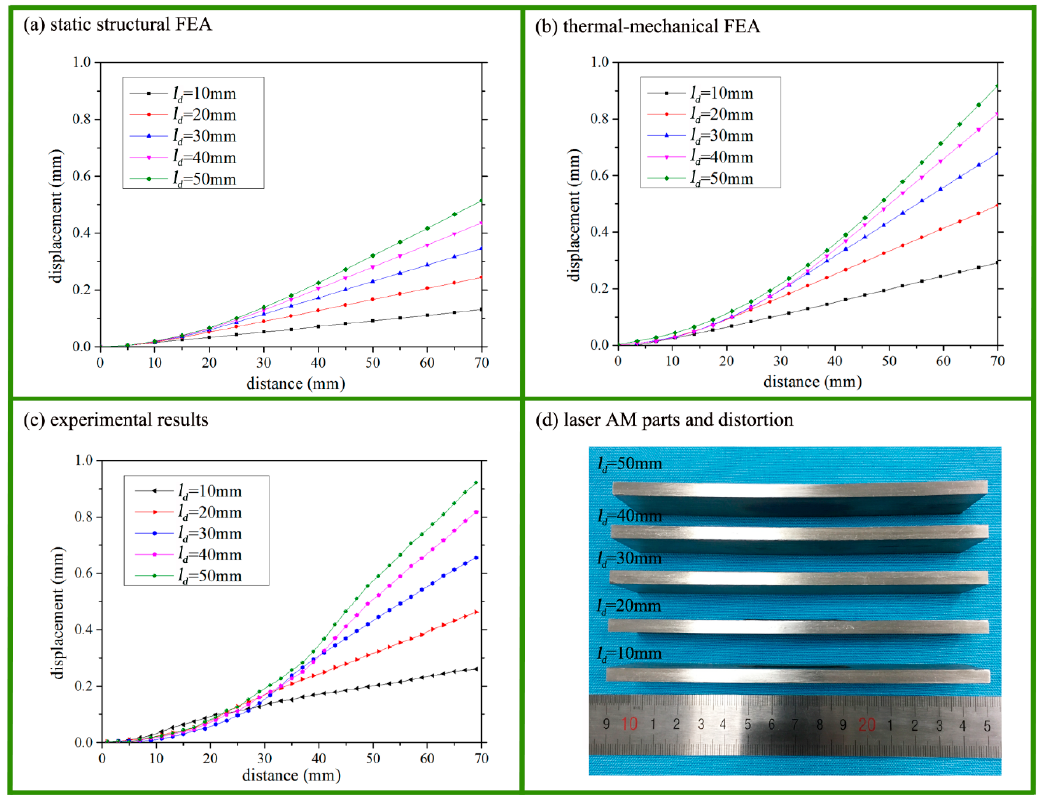
Figure 5. Displacement curves for the various l d values with the three methods. ( a ) The displacement curves for various l d values via the static structural FEA when the F ds is 10 kN. ( b ) The displacement curves for various l d values via the thermal-mechanical FEA. ( c ) Experimental displacement curves for the various l d values. ( d ) Experimental samples of the various l d .